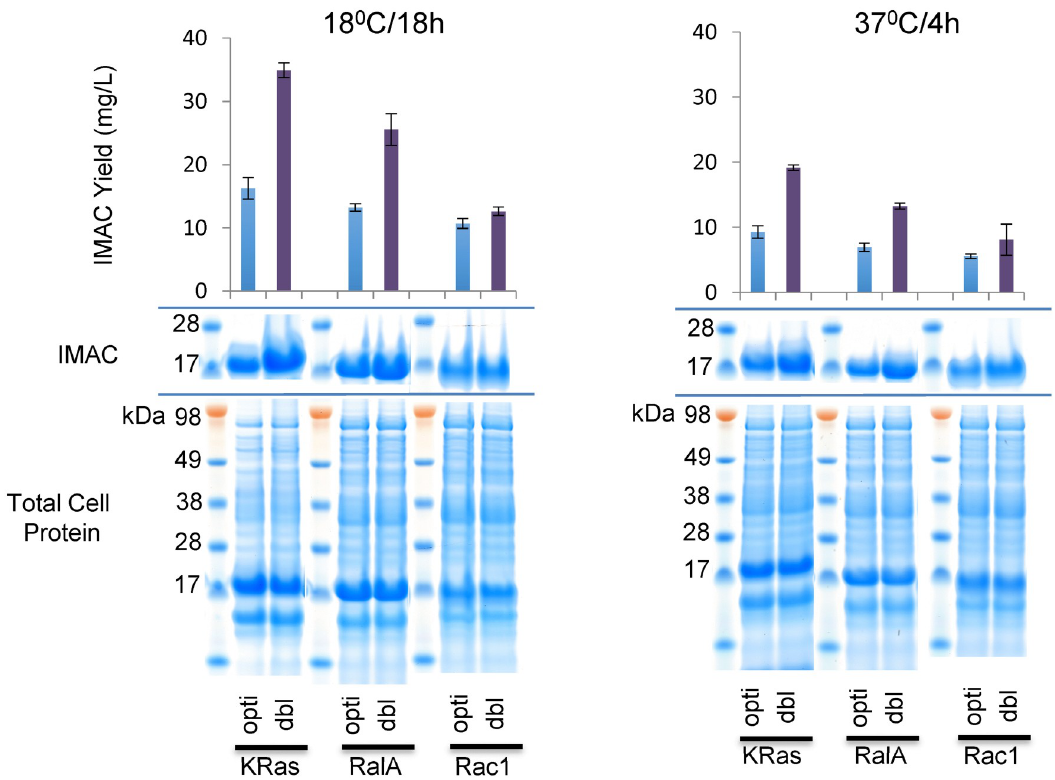
Fig 7. Improved soluble yield offers options for workflow efficiency. A comparison between the performances of clones demonstrates that the yield from the dbl modified clone following a short 4 hour expression at 37˚C is roughly equivalent to the output from the fully optimised clone following an overnight 18˚C expression batch. Thus the improved performance offers the opportunity to compress expression times if throughput rather than yield is the most important